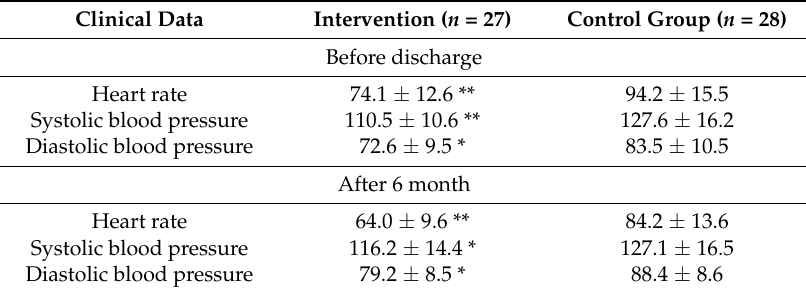
Table 3. Heart rate and blood pressure response.